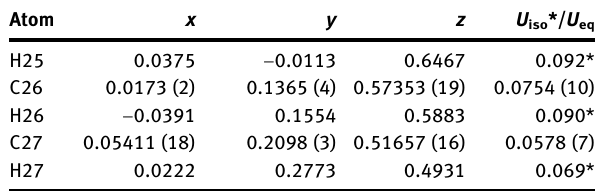
Table  : Fractional atomic coordinates and isotropic or equivalent isotropic displacement parameters (Å 